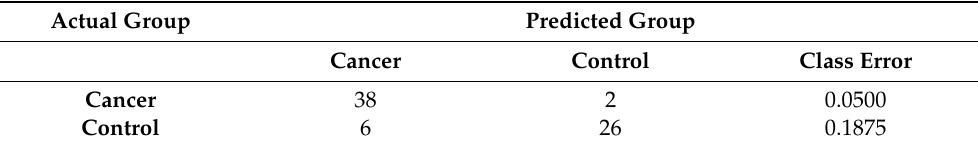
Figure 15. Hierarchical clustering using the top 10 discriminatory metabolites for the detection of endometrial cancer after exclusion of women with type 2 diabetes mellitus (training set: n = 72, cancers = 40, controls = 32). Discriminatory metabolites were based on mean decreasing accuracy metric from random forest analysis. The difference in intensities of the top 10 metabolites by cancer-control status is shown. Each coloured cell in the map represents the scaled/relative concentration of indicated metabolite. Metabolites are clustered along the vertical axis and subjects along the horizontal axis. Metabolites starting with X are unnamed with unknown pathways. Table 7. Random forest diagnostic accuracy developed based on the training set made from 80% of endometrial cancer cases and controls after exclusion of those with type 2 diabetes mellitus ( n = 72, cancers = 40, controls = 32).